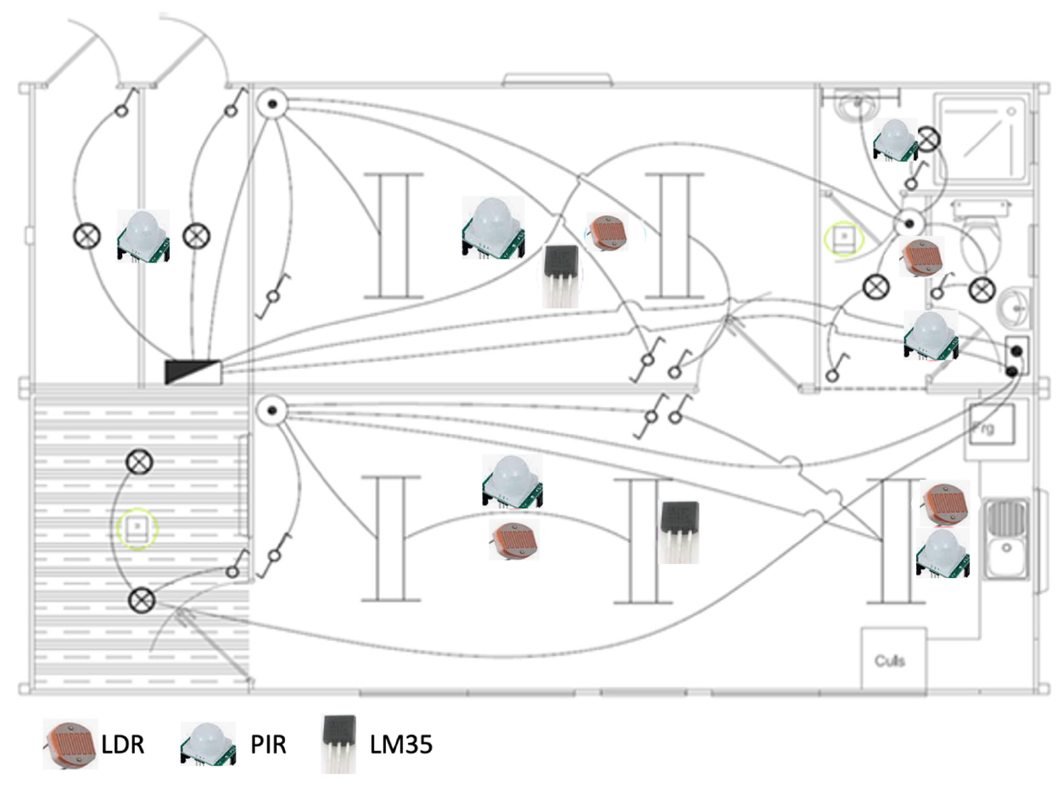
Figure 15. Electrical installation and sensors’ position (LDR, light sensor, PIR, movement sensor and LM35 temperature sensor) in UDES’ solar smart house.